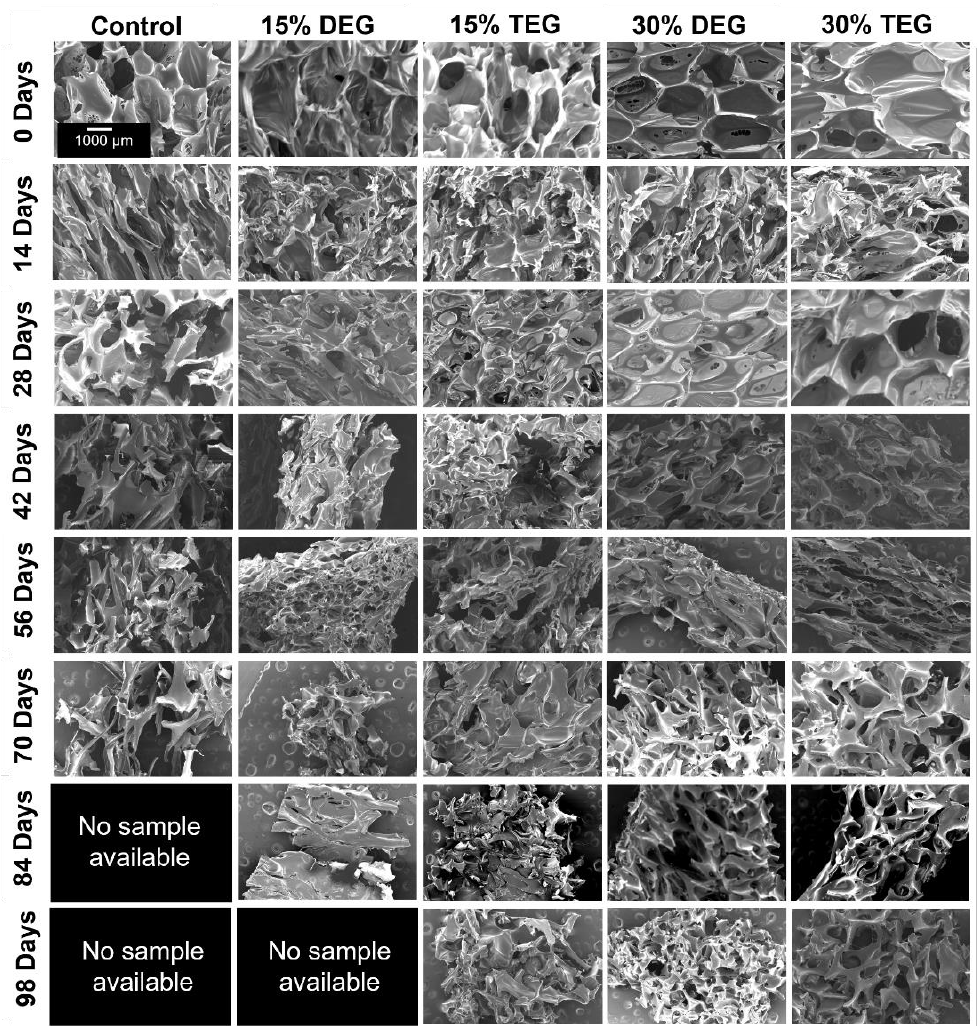
Figure 5. SEM micrographs depicting the overall pore morphology observed during degradation in oxidative media, 3% H 2 O 2 , over 98 days. Scale bar of 1000 µm applies to all images.